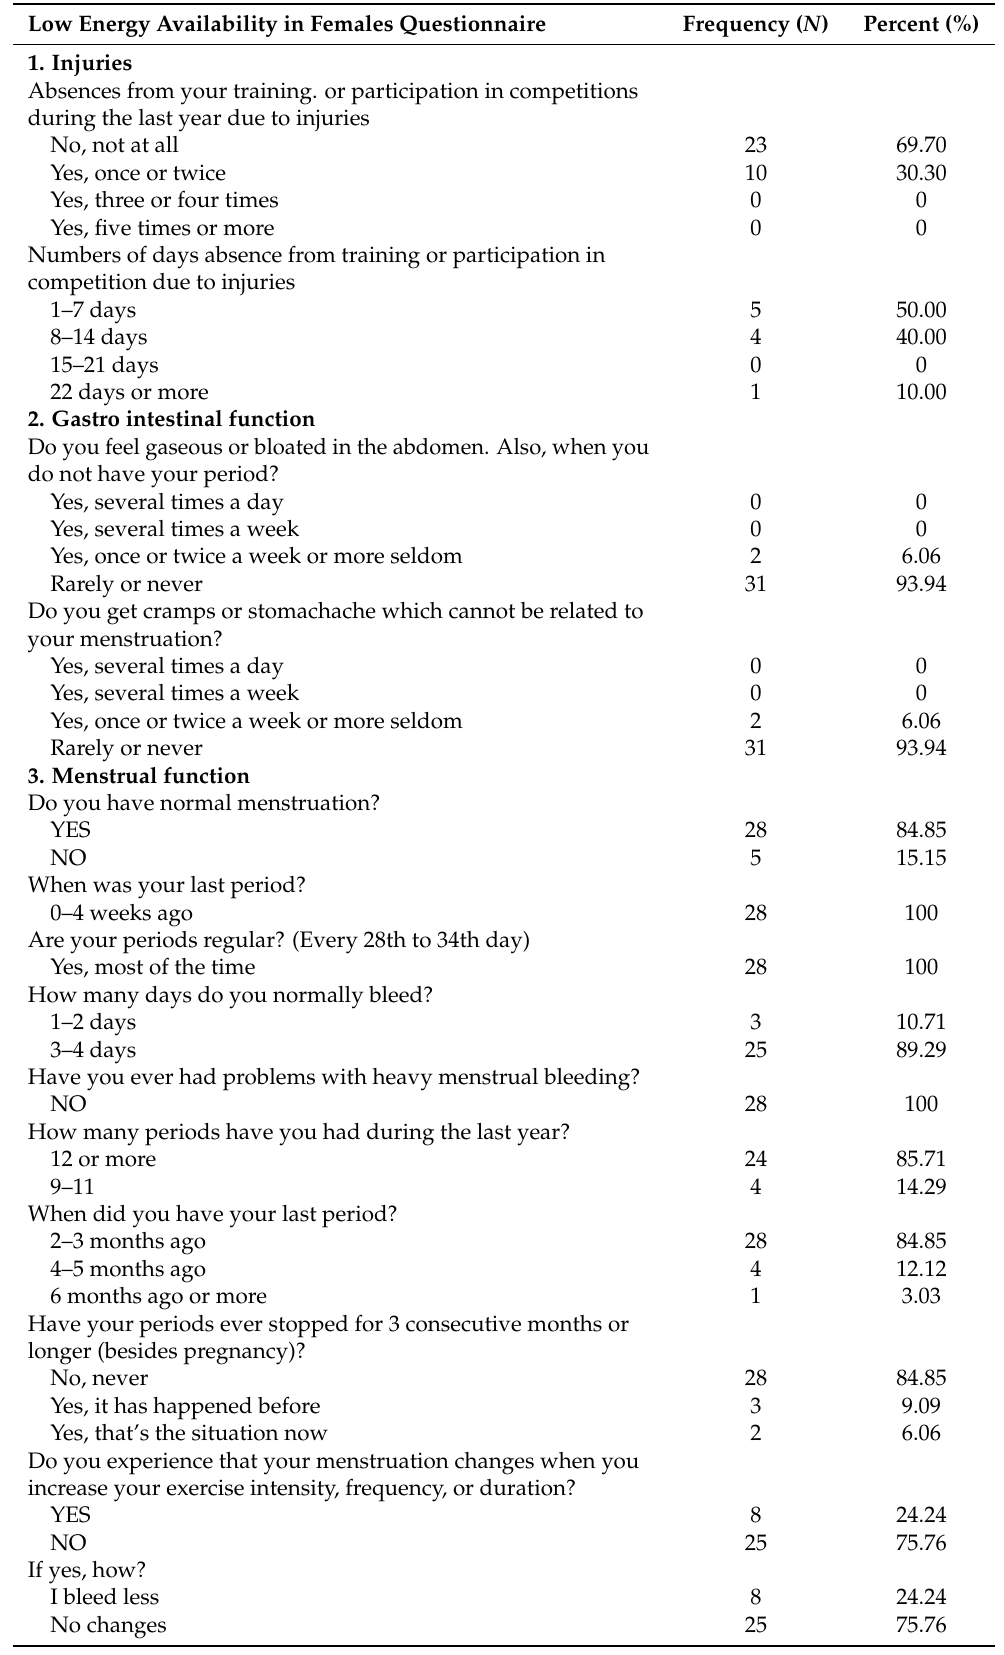
Table 2. The most important questions of LEAF-Q and the numerical answers provided by the kayakers in the